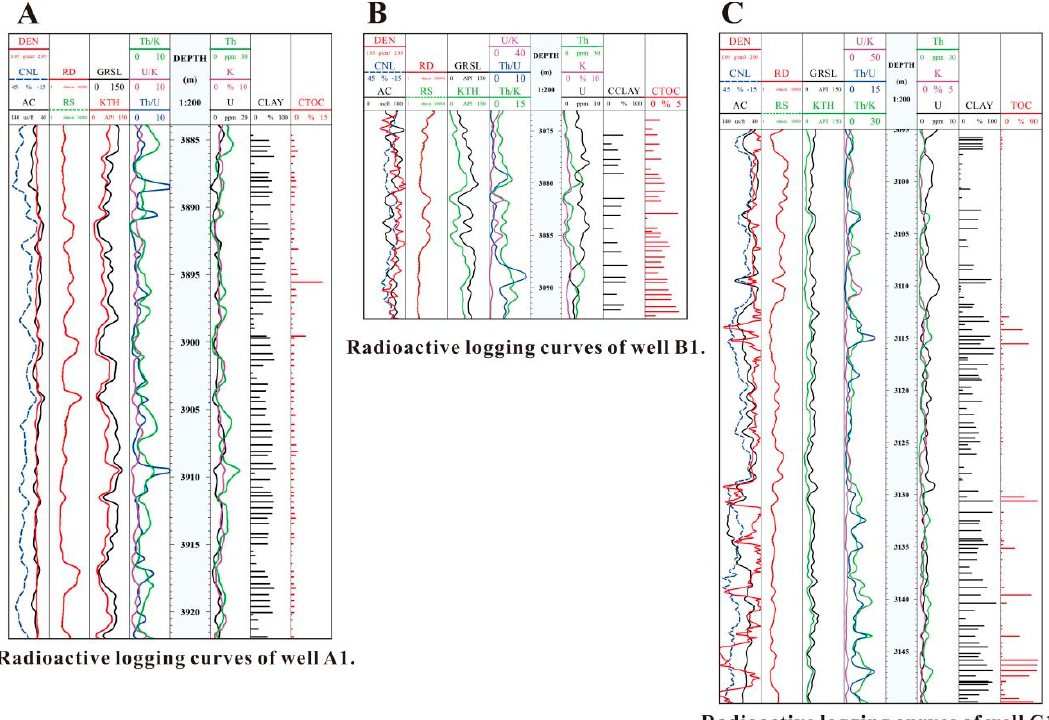
Figure 4. Radioactive logging curves of wells A1 ( A ), B1 ( B ), and C1 ( C ).